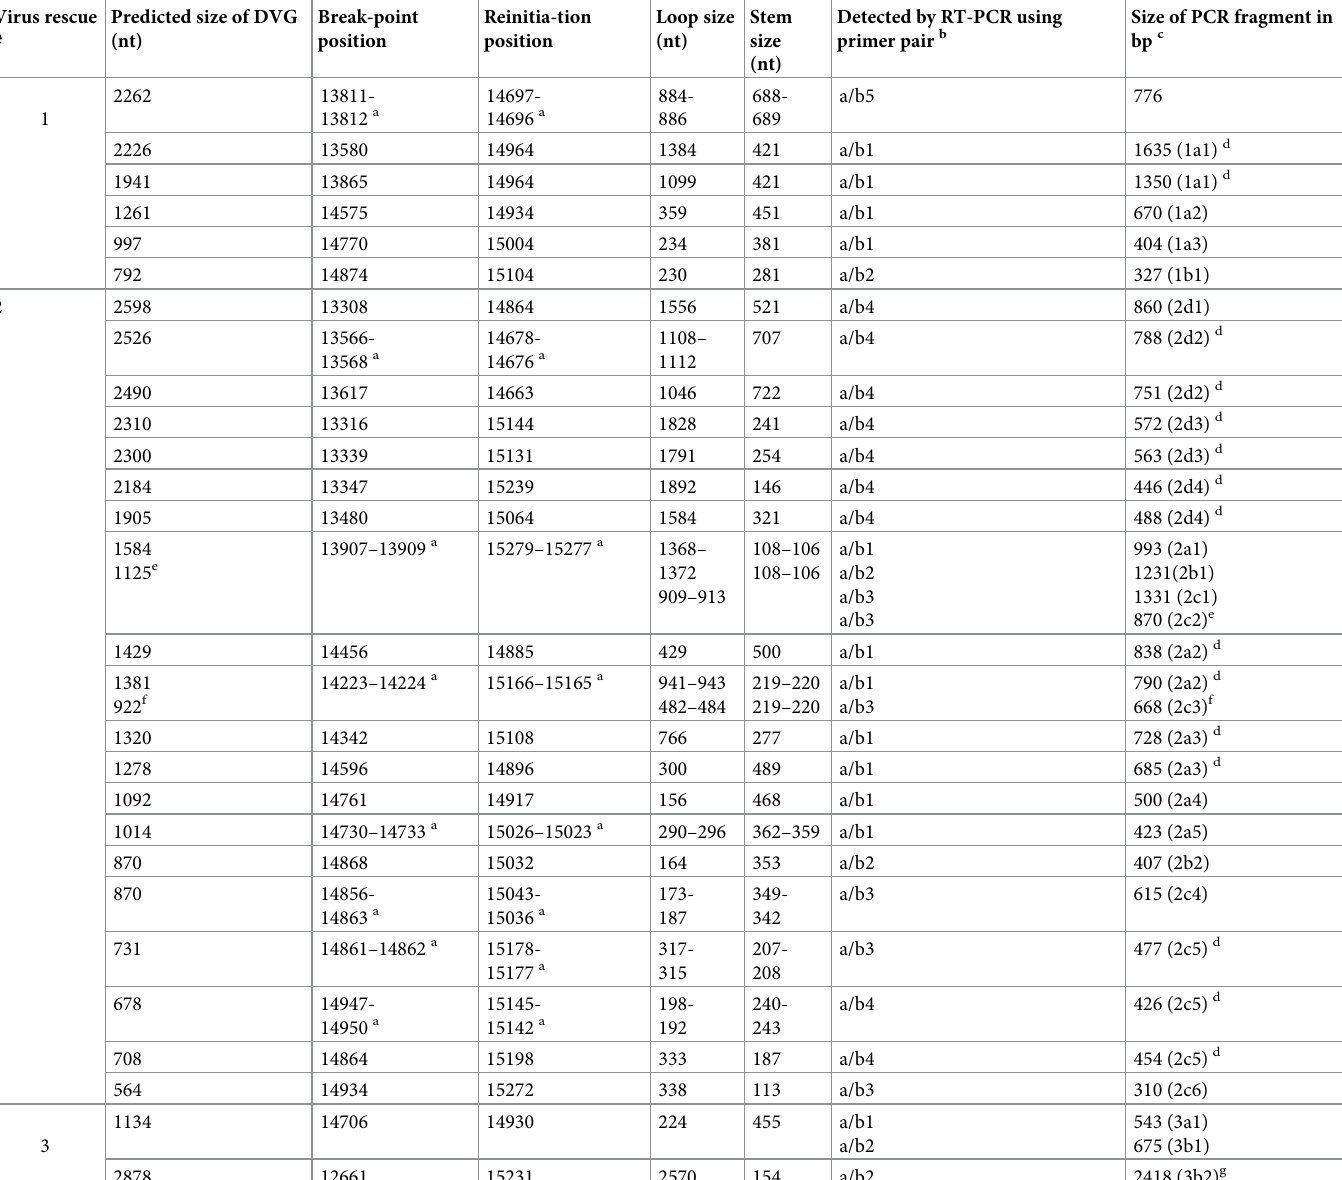
Table 1. 5’ copyback DVG genomes identified in viruses #1, #2 and #3 employing DVG-specific RT-PCR. Virus rescue